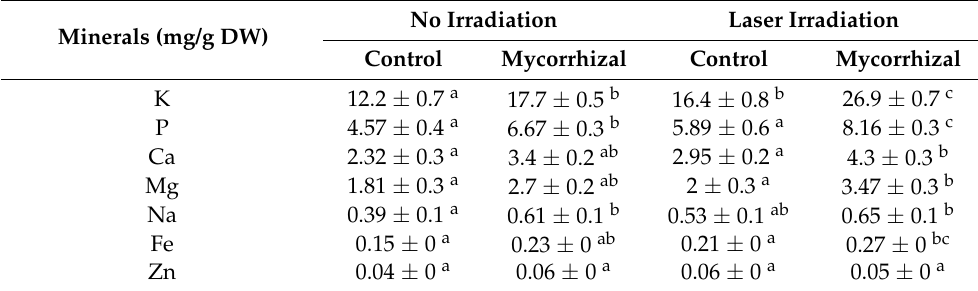
Table 3. Effect of mycorrhiza and laser light on mineral uptake by P. graveolens .